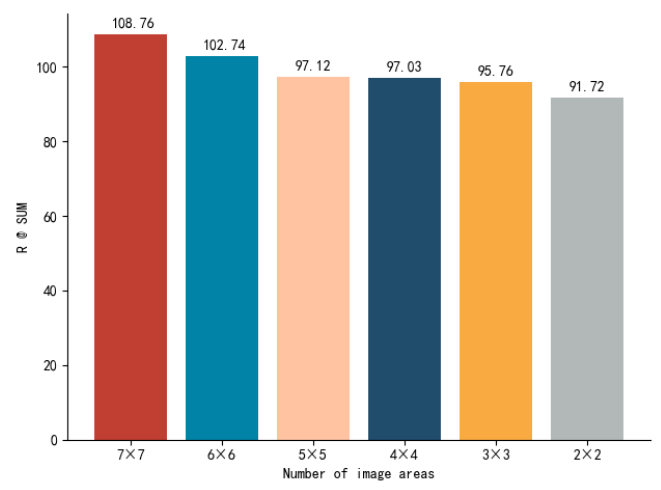
Figure 9. Variations of model precision over RSICD dataset with the number of image areas.